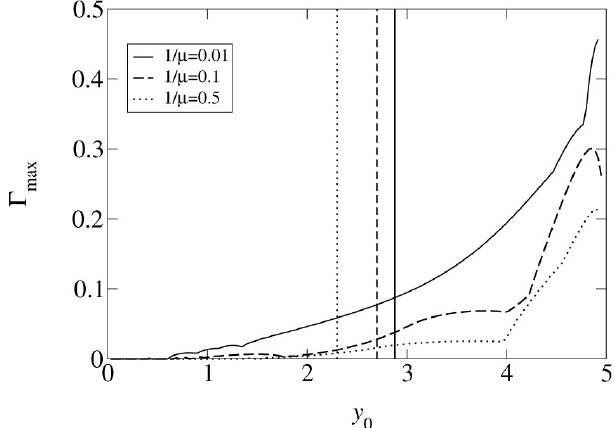
Fig. 17. Maximum growth rate vs. pump wave wave number, for α = 0 . 04 and various temperatures. The vertical lines indicate the value of y 0 at which d ω/ d k = 0.